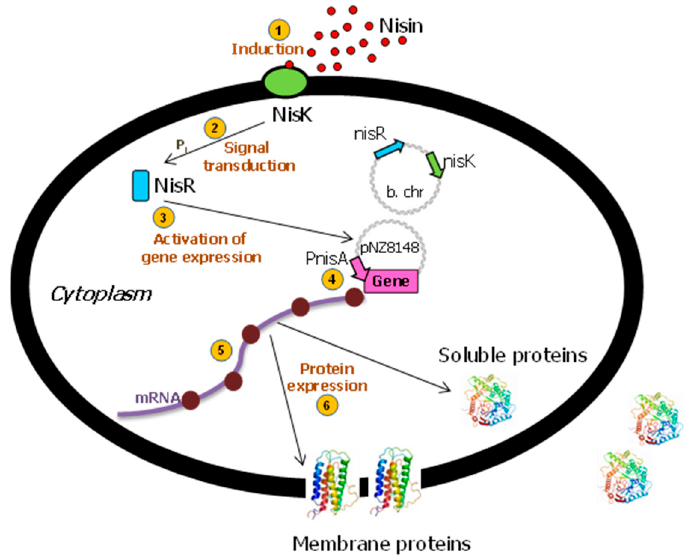
Figure 1. The Nisin-Controlled Gene Expression (NICE) system in L. lactis . After the detection of nisin by the membrane-located sensor protein (NisK) 1 (cid:13) , this histidine protein kinase autophosphorylates and transfers its phosphate group to activate the cytoplasmic response regulator NisR 2 (cid:13) . Activated NisR 3 (cid:13) subsequently induces transcription controlled by the PnisA promoter 4 (cid:13) . After transduction, 5 (cid:13) and depending on the presence or absence of the corresponding targeting signals, the protein is either expressed into the cytoplasm or the membrane, or secreted into the external medium 6 (cid:13) . B. chr: bacterial chromosome. Adapted from [12,25].